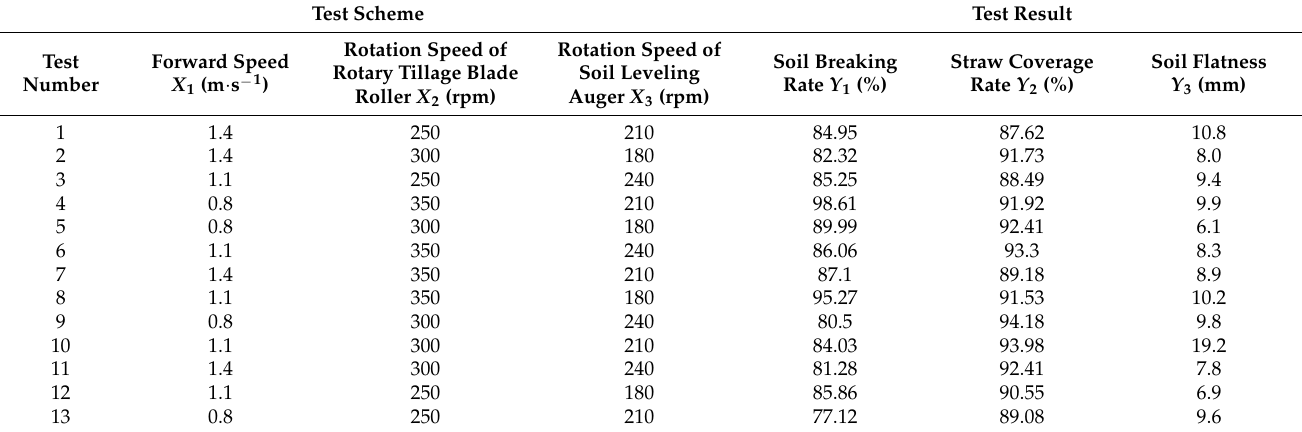
Table 3. Test scheme and result of parameter optimization test for seedbed preparation machine. Test